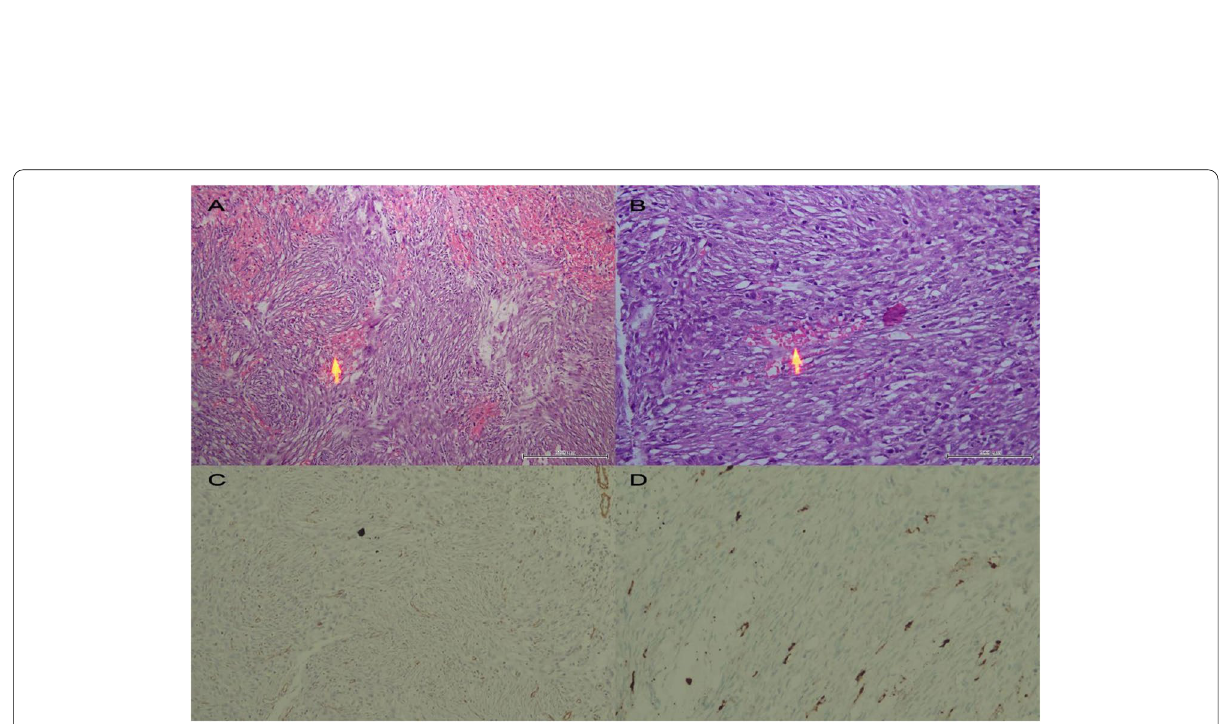
Fig. 2 A , B Cross section of soft tissue mass sample with different power of magnifications fibroblastic spindle cells arranged in a fascicular pattern. C SMA positive immunostaining of cells of nodular fasciitis. Magnification Magnification = ×